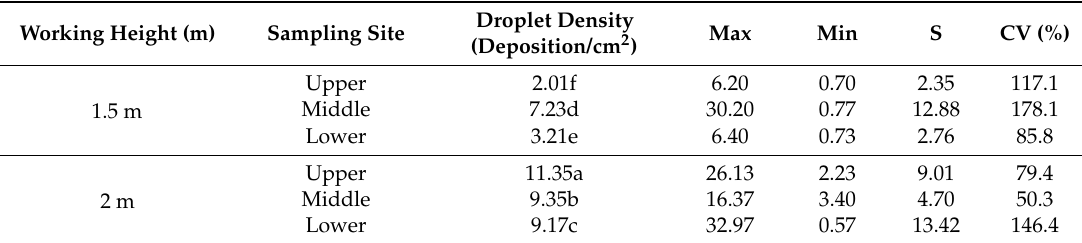
Table 5. Distribution of droplet